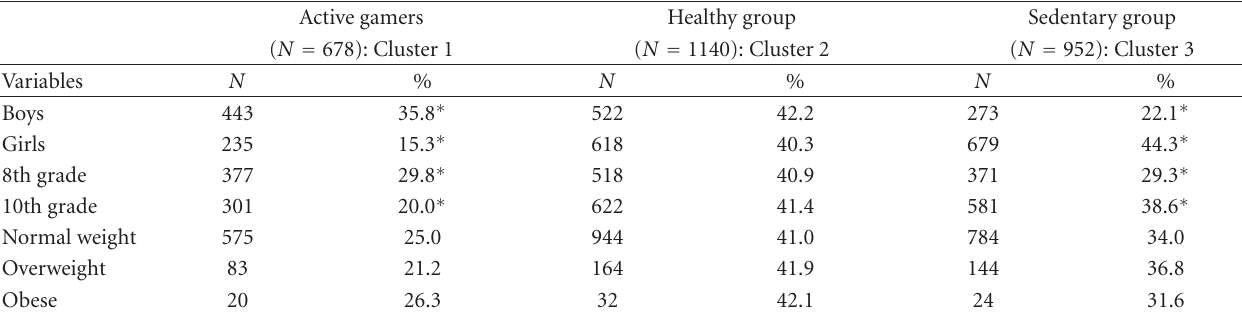
Table 1: Gender, school grades, and weight status prevalence within